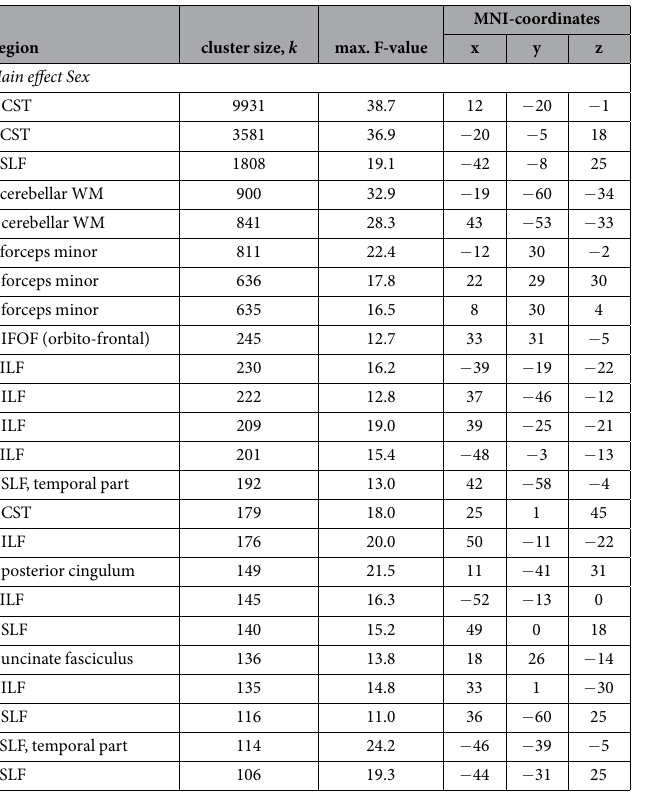
Table 2. Results of a whole-brain, voxel-wise 2 (Sex) by 2 (Sexual orientation) ANOVA, including all four cisgender groups; results are displayed at p FWE < 0.05, cluster threshold of t = 2.3, and a minimal cluster size of k ≥ 100 voxel (1 mm 3 voxel size); CST = cortico-spinal tract; SLF = superior longitudinal fasciculus; WM = white matter; IFOF = inferior fronto-occipital fasciculus; ILF = inferior longitudinal fasciculus; L = left; R =